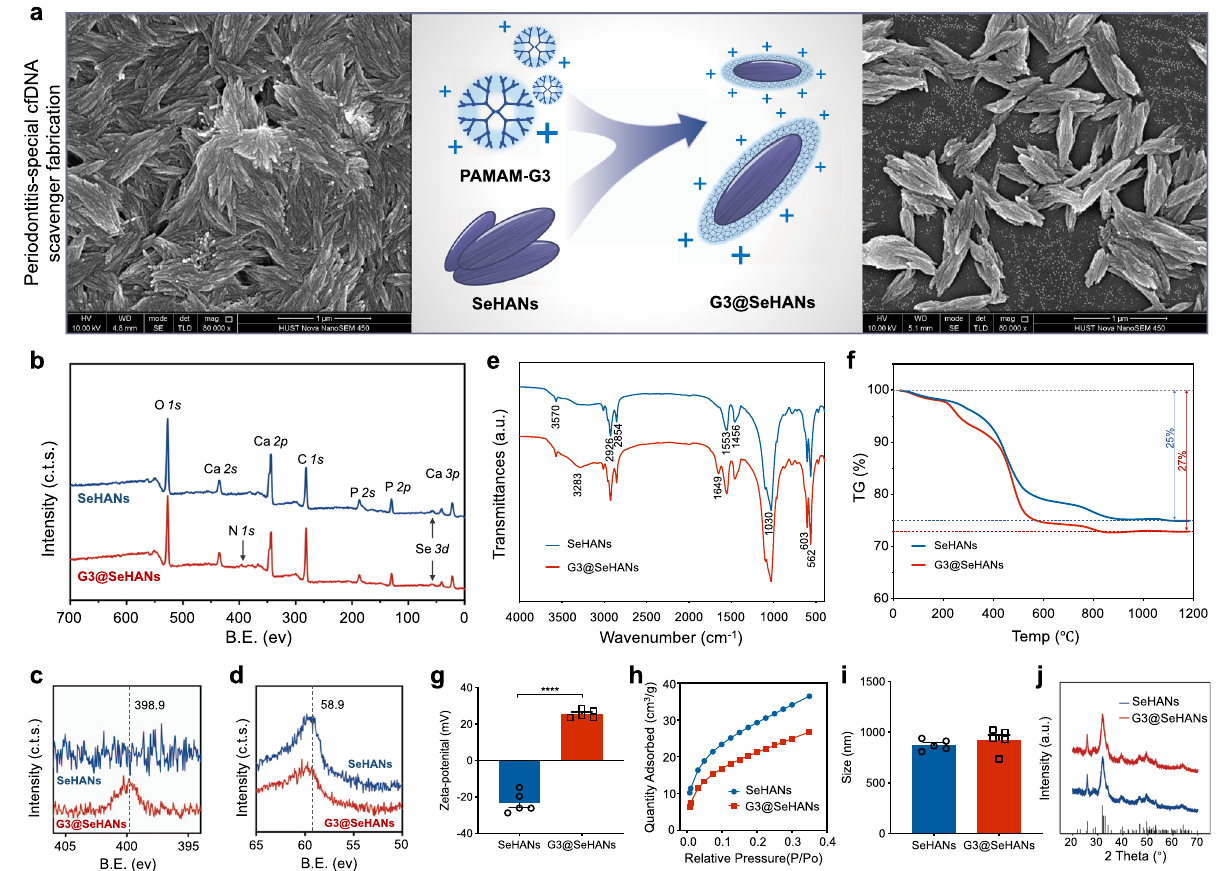
Fig. 2 | Characterization of G3@SeHANs. a SEM imaging of SeHANs before and after coating with PAMAM-G3. b – d XPS spectra. The N 1s photoelectron peak (398.9eV)ispresentonlyinG3@SeHANs;Se 3d peaks(58.9eV)arepresentinboth SeHANs and G3@SeHANs. Representative images were from 3 independent experiments. e FTIR spectra. Both SeHANs and G3@SeHANs exhibit characteristic phosphate bands at 562, 603, and 1030cm − 1 , and bands corresponding to O-Se-O bending vibration (783cm − 1 ) and hydroxyl groups (3570cm − 1 ).Peaks due to amino stretching vibration (3283cm − 1 ) and bending vibration of the amide N-H